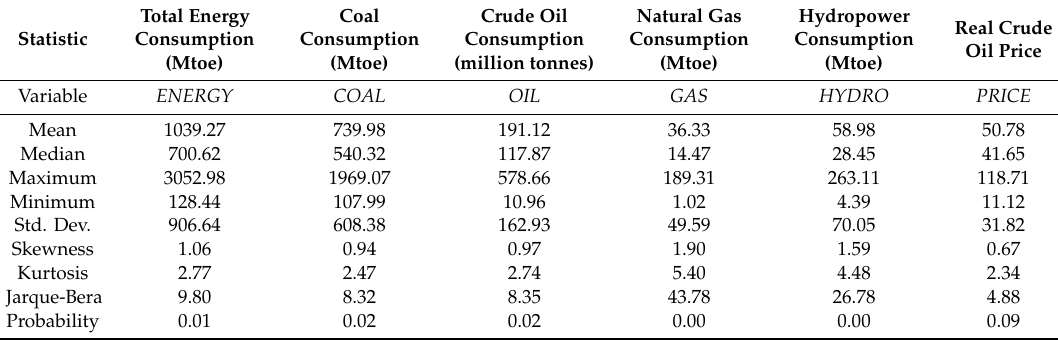
Table 1. Descriptive statistics of the data.